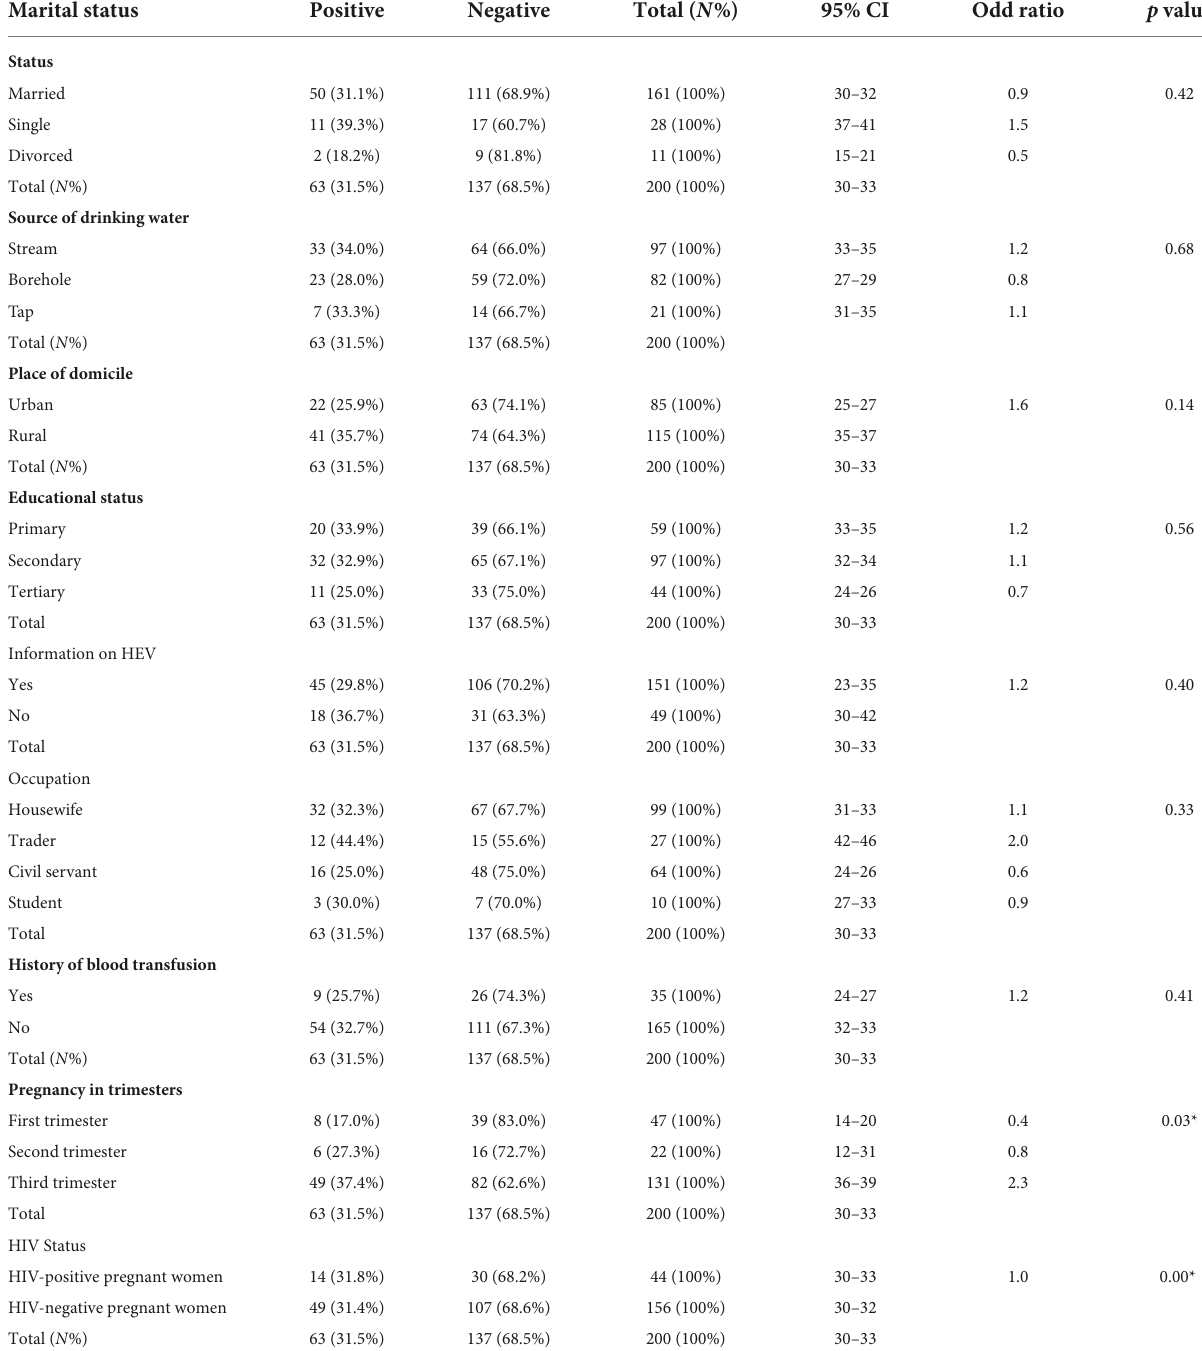
TABLE 1 Sociodemographic characteristics of study participants and HEV